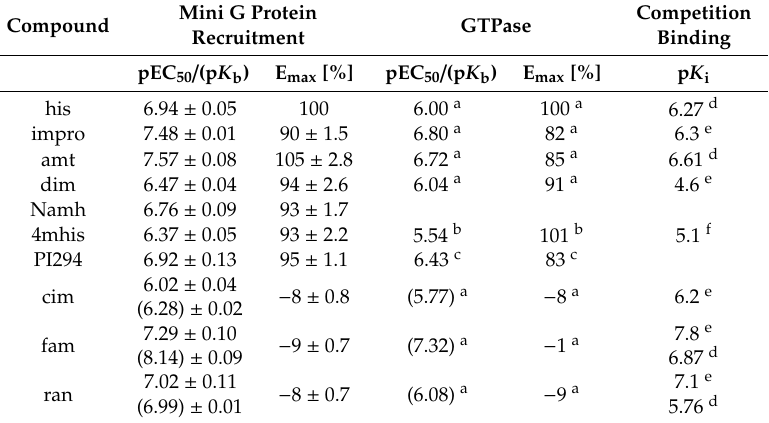
Table 2. Potencies (pEC 50 / p K b ) and e ffi cacies (E max ) of ligands at the H 2 R explored in the mini-G protein recruitment assay. Data represent means ± SEM of at least three independent experiments ( n ≥ 3), each performed in triplicate. Functional data obtained in steady-state GTPase assays and ligand binding a ffi nities (p K i ) determined in radioligand competition binding assays are included for